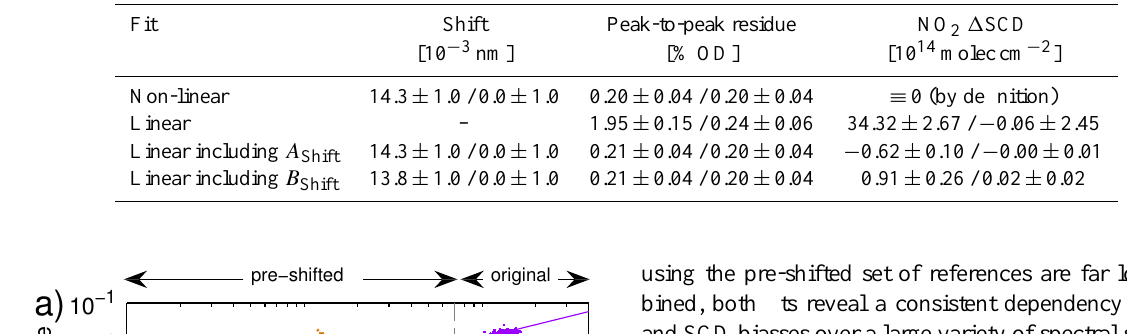
Table 4. Comparison of the results of the non-linear and the different linear fits applied to SCIAMACHY measurements on 1 June 2006. Spectral shift, fit residues, and NO 2 SCD bias are displayed as mean ± standard deviation, first for the original, then (separated by “/”) for the pre-shifted set of references.